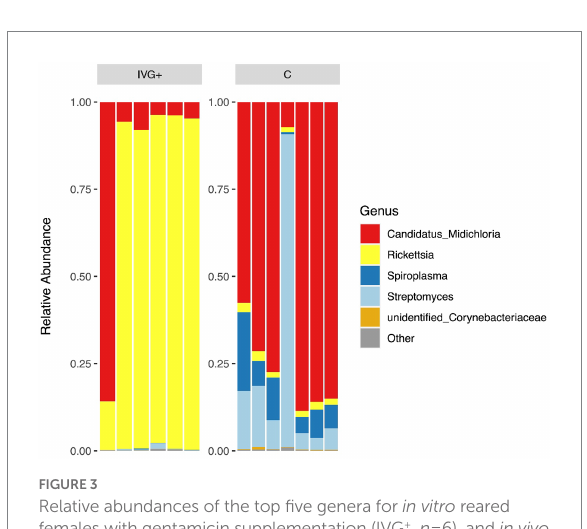
FIGURE 3 Relative abundances of the top five genera for in vitro reared females with gentamicin supplementation (IVG + , n = 6), and in vivo reared females (C, n = 7).